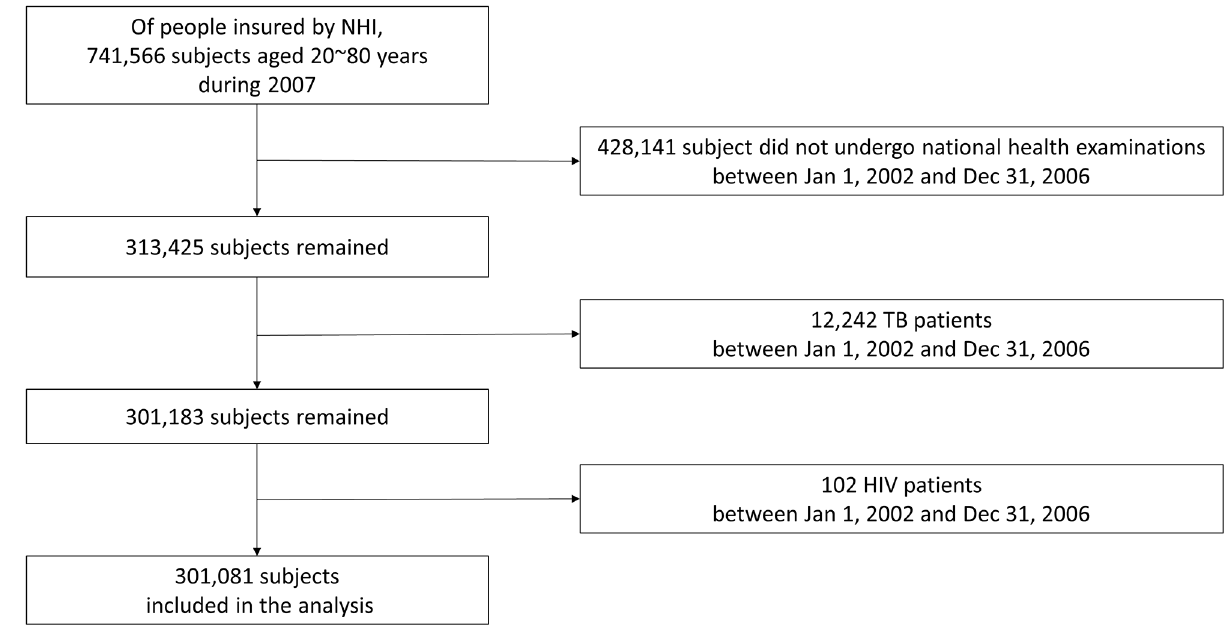
Fig 1. Study population. NHI indicates National Health Insurance; TB, tuberculosis; HIV, human immunodeficiency virus.